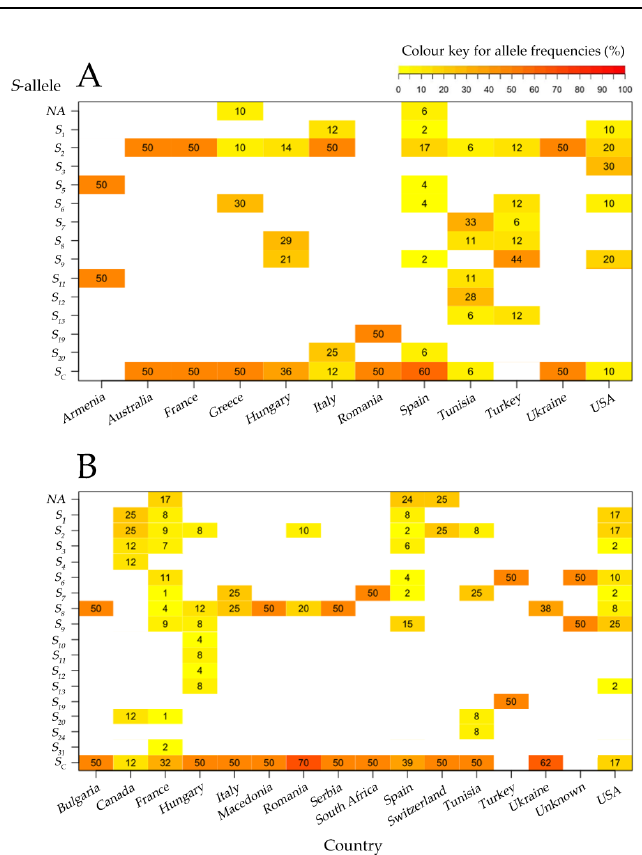
Figure 3. Heatmaps of allele frequencies in traditional cultivars ( A ) and cultivars from breeding programs ( B ) for each country of origin using “PopGenReport” v. 3.0.4 R package. Cell color indicates the proportion of the total number of alleles, and the numbers within a cell show the percentage of the number of alleles in each country. The frequency of each S -allele was calculated in each country within each group of accessions, showing statistically significant relationships ( p < 0.05) between S- alleles and countries in the groups of both traditional cultivars and releases from breeding programs.